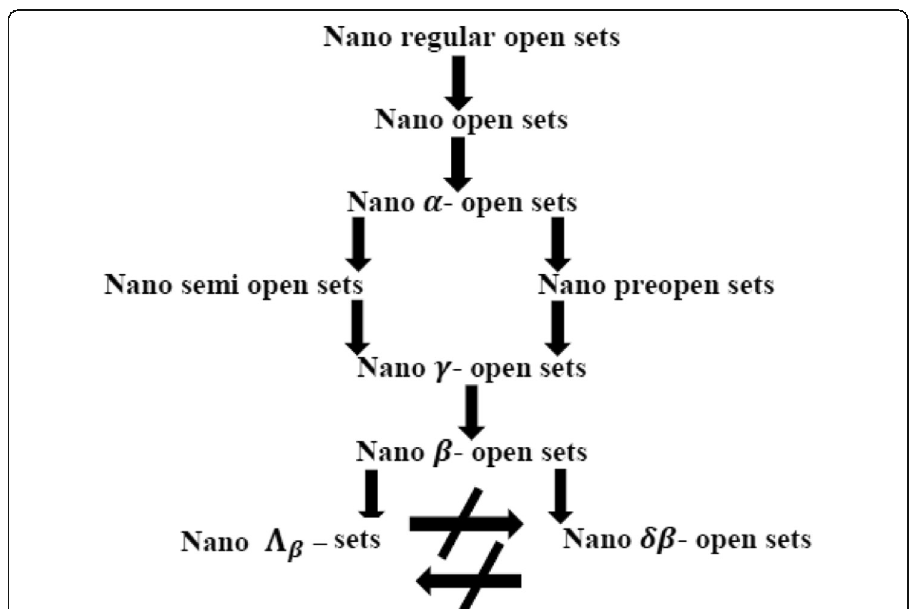
Fig. 3 The relationships between nano ∧ β -sets and the other nano near